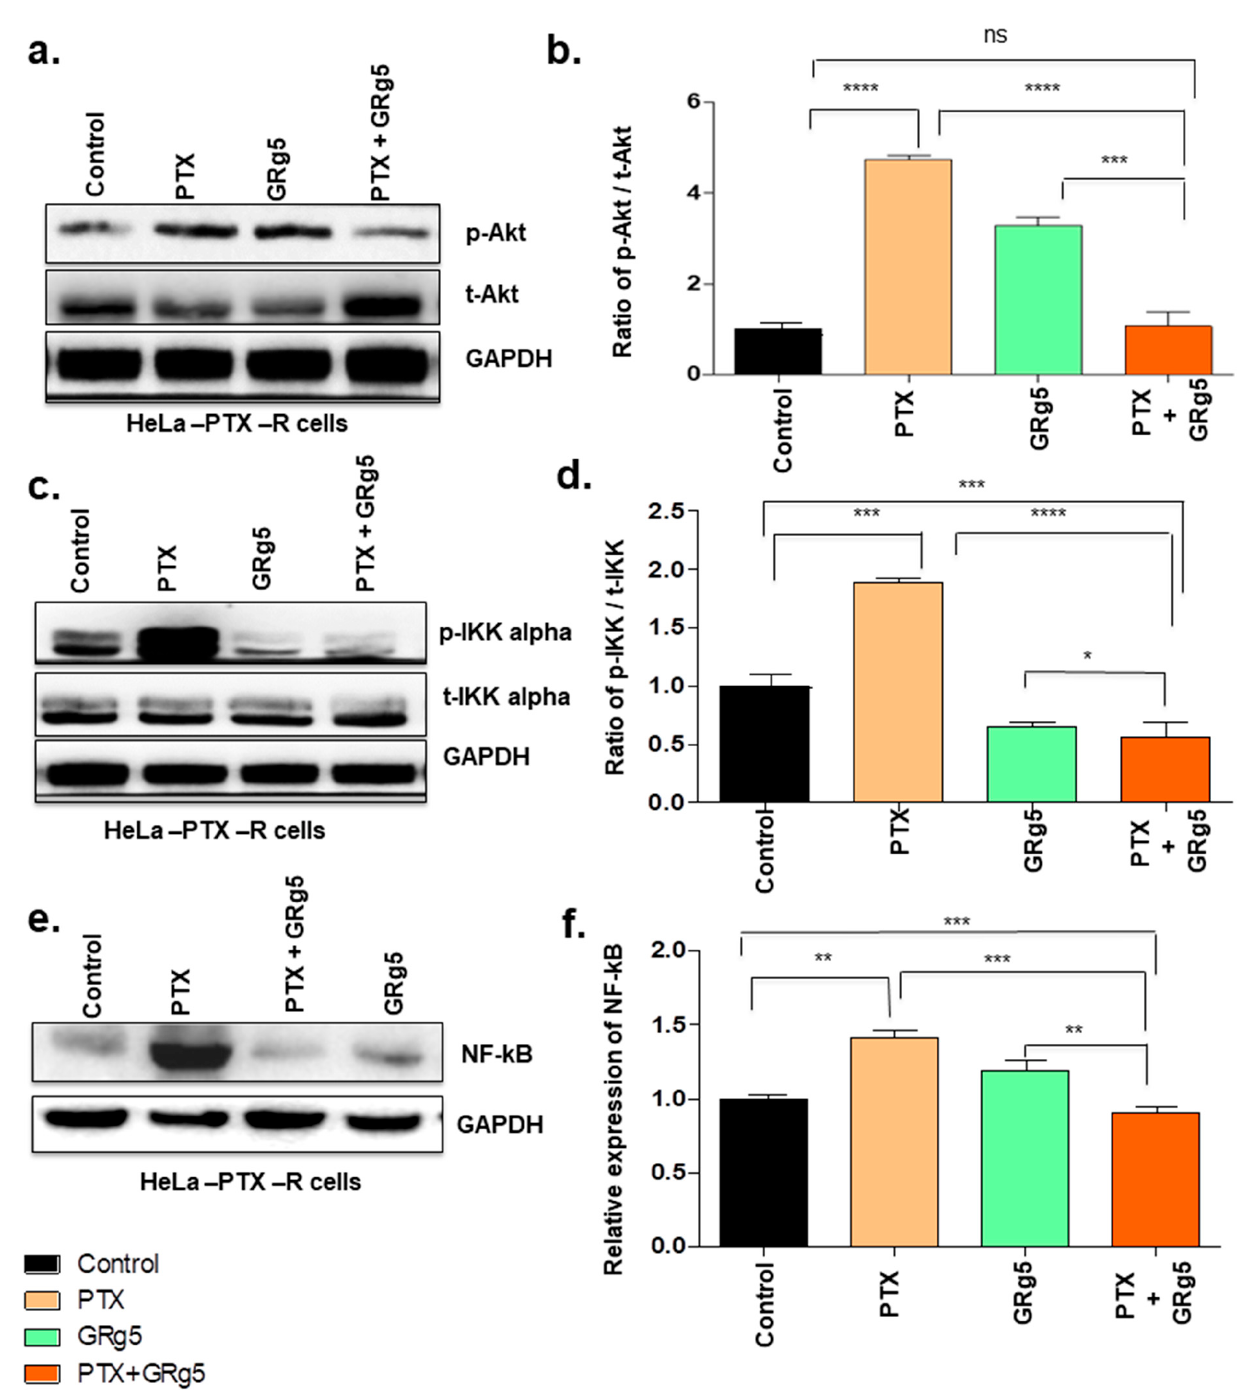
combination with GRg5+PTX as compared to control, PTX alone, or GRg5 alone treat- NF- κ B protein level (Figure 11e,f) when the HeLa-PTX-R cells were treated in combination ment ( p < 0.001). with GRg5+PTX as compared to control, PTX alone, or GRg5 alone treatment ( p < 0.001).